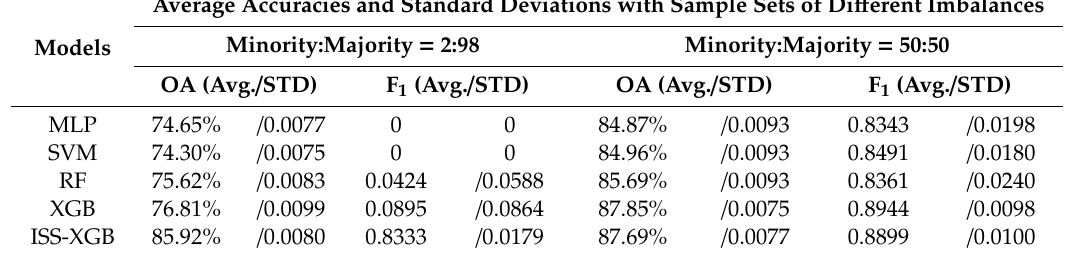
Table 3. Average accuracies and standard deviations of Area 6 for 100 trials of 5 approaches.